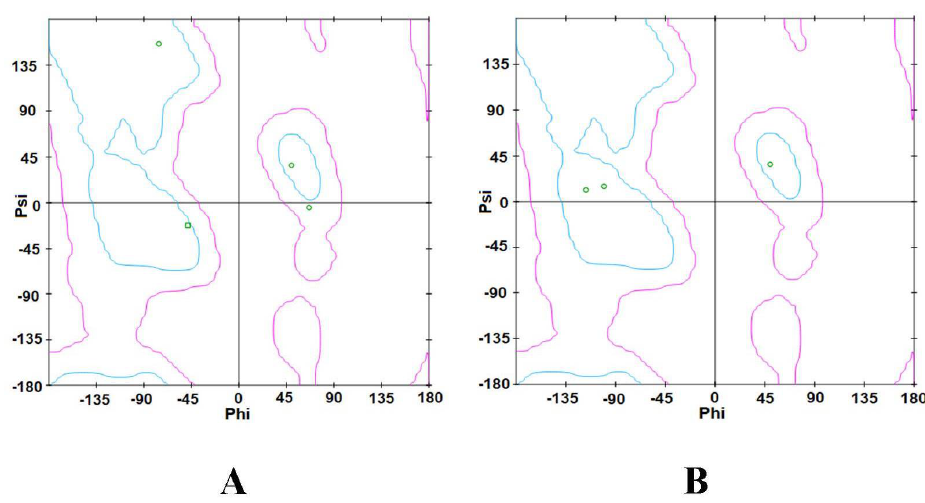
Figure 17. Ramachandran plot of the ligands with highest binding affinities with interacting amino acid residues: ( A ) Ramachandran plot of ergosterol peroxide, and ( B ) Ramachandran plot of 14 − deoxy − 14,15dehydroandrographolide.